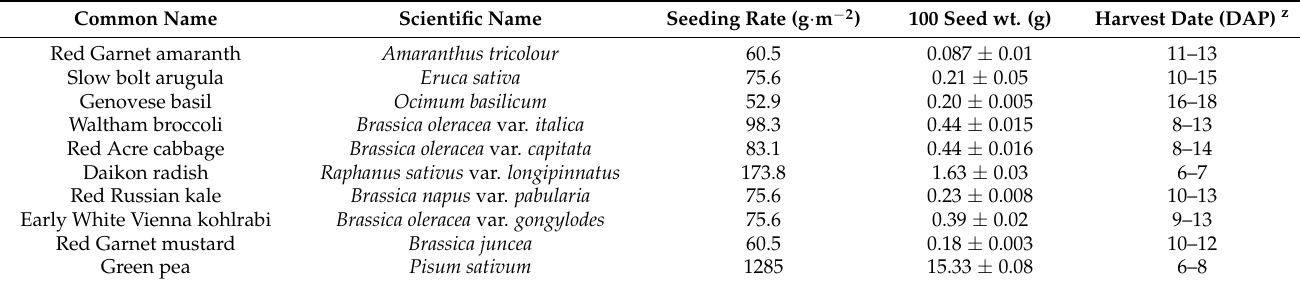
Table 1. Common name, scientific name, seeding rate, 100 seed weight, and harvest date of ten species grown as